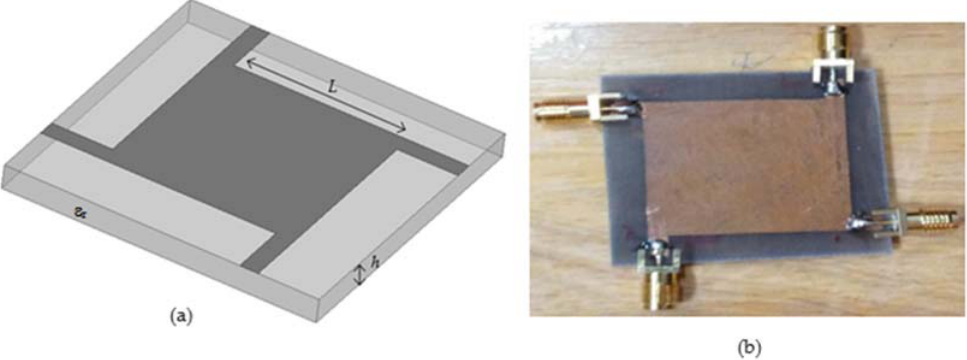
Figure 4. Square Patch Crossover (SPC). ( a ) Schematic of SPC; ( b ) Photo of the fabricated prototype.